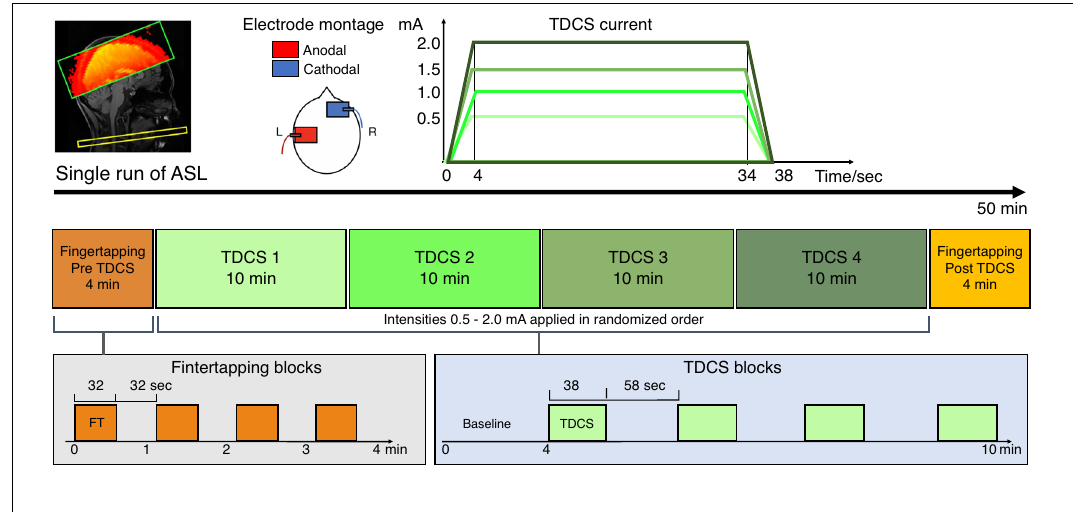
Figure 5. Experimental design. Top: TDCS was applied with 5 × 7 cm 2 square electrodes with anodal on C4 and cathodal on the right supraorbital area. We applied four different current intensities of 0.5, 1.0, 1.5 and 2.0 mA. Current waveform consisted of 4 s ramp-up, 30 s stimulation and 4 s ramp-down. Middle and bottom: We performed a single run of pcASL, with a block of 4 min finger-tapping (FT) followed by four consecutive 10 min blocks of stimulation (TDCS) with randomized order of intensities, ending with a block of 4 min FT. Total duration of the scanning session is approximately 50